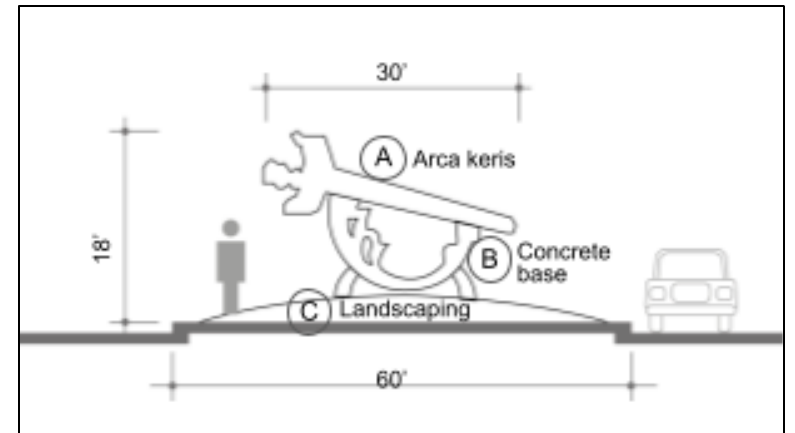
Figure 3. Detailed illustration of Arca Keris.